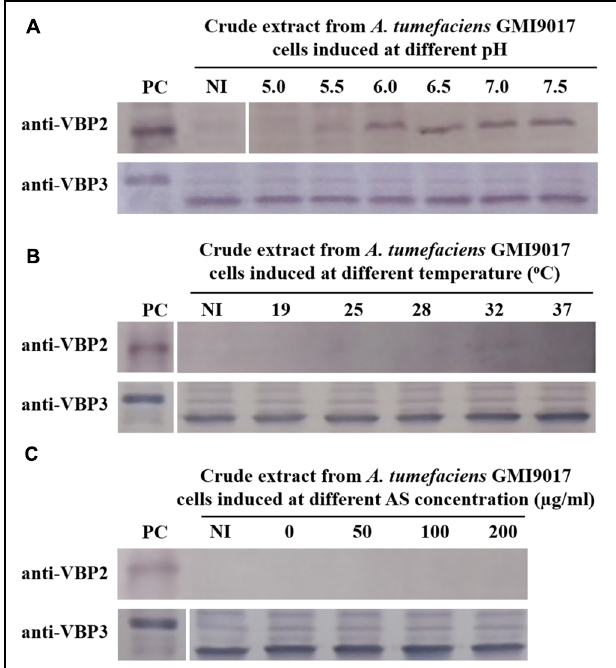
FIGURE 3 | Expression of vbp2 and vbp3 in A. tumefaciens strain GMI9017 at different pHs (A), temperatures (B), and AS concentrations (C). A. tumefaciens strain GMI9017 cells were induced under the indicated pH, temperature or AS concentration. Crude extracts from the differentially induced GMI9017 cells were separated using SDS-PAGE and then analyzed by Western blotting. PC, positive control, crude extracts from E. coli cells expressing vbp2 (up) or vbp3 (down) with His-tag. The antibodies used in this study are listed on the left. NI: crude extracts from GMI9017 cells not induced in IB medium. (A) Effect of pH on the expression of vbp2 and vbp3 in A. tumefaciens GMI9017. The temperature is 25 ◦ C and AS concentration is 100 µ g/ml. (B) Effect of temperature on the expression of vbp2 and vbp3 in A. tumefaciens GMI9017. The pH is 5.5 and AS concentration is 100 µ g/ml. (C) Effect of AS concentration on the expression of vbp2 and vbp3 in A. tumefaciens GMI9017. The pH is 5.5 and temperature is 25 ◦ C.